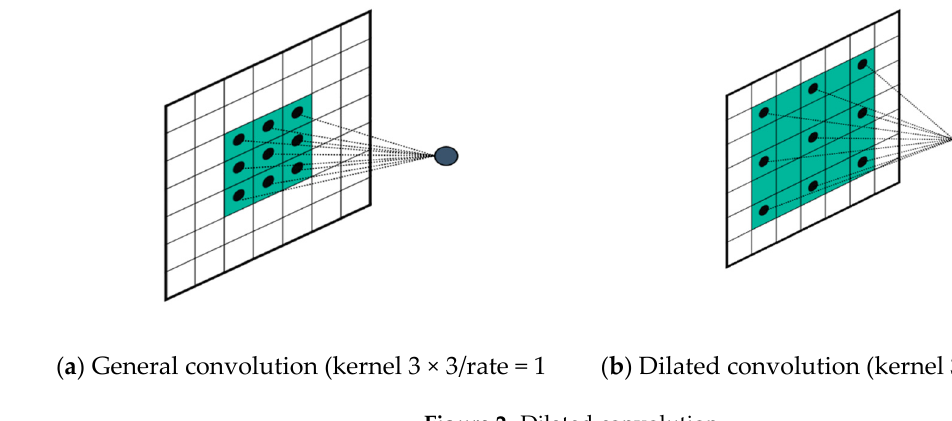
Figure 2. Dilated convolution.